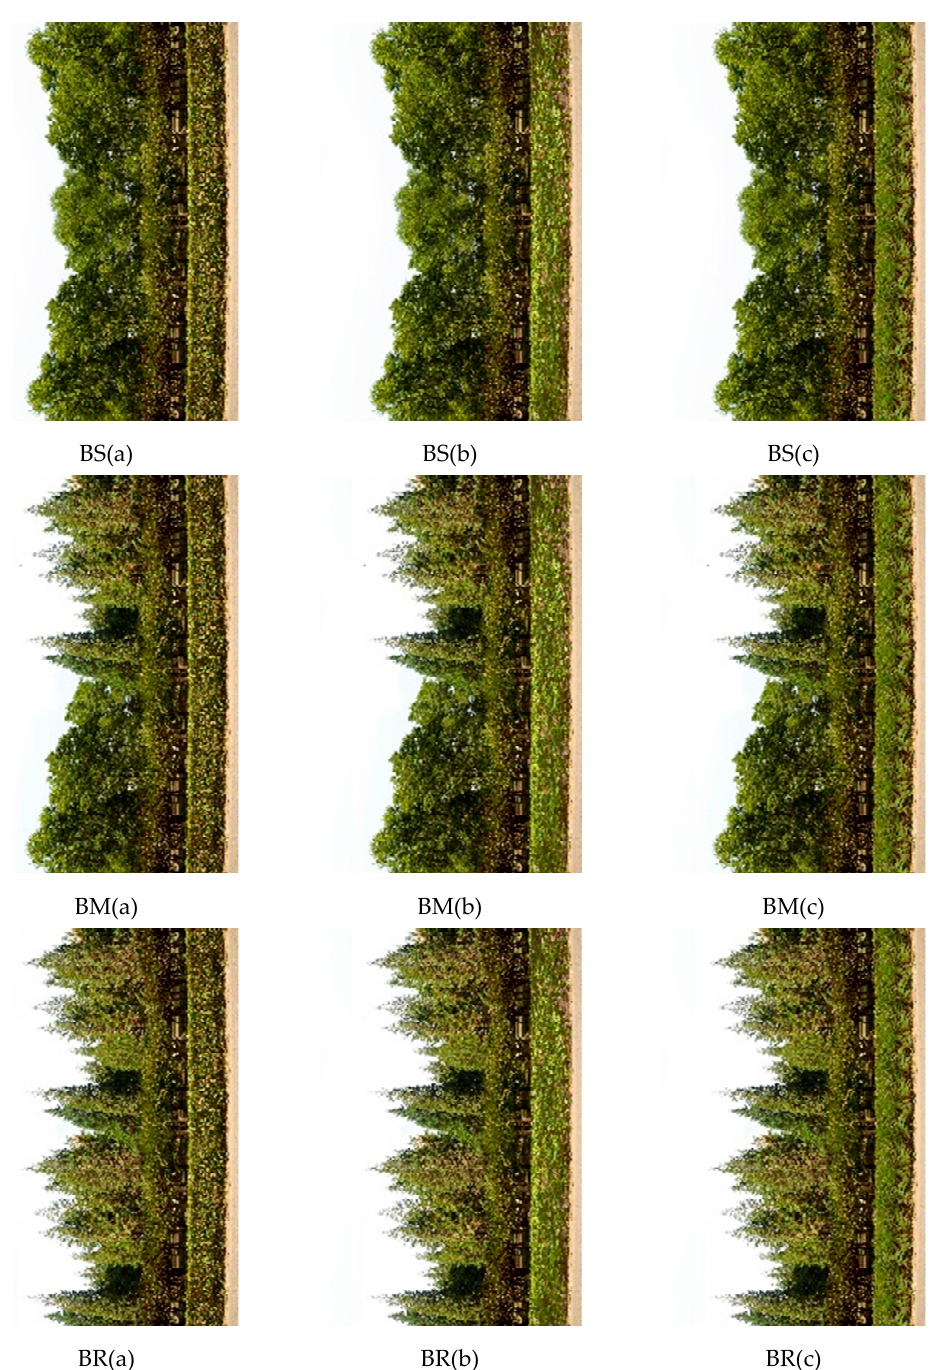
Figure 1. The original all-green landscape with all elements in green with different background and foreground configurations and a consistent midground spatial layer. Background (B) varied by landscape texture type through soft (S) with Sophora japonica , rigid (R) with Juniperus chinensis , or mixed (M) with soft and rigid texture trees; midground plants were Prunus cerasifera in all images; and foreground plant types were Euonymus japonicus ( a ), Hosta plantaginea ( b ), or Iris tectorum ( c ). Thus, by example the BM( a ) was a mixed background and Euonymus japonicus in the foreground.